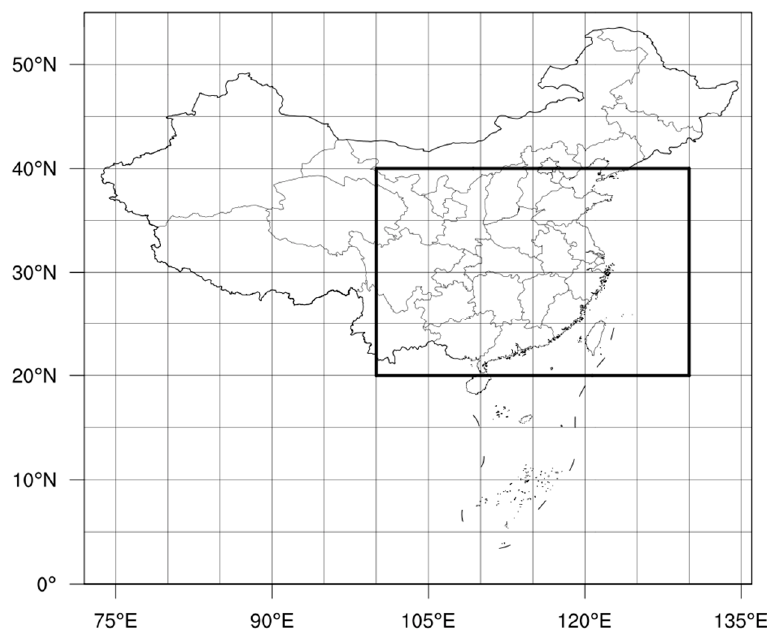
Figure 1. Analysis domain: the boundaries (small rectangle) of the southeast region (covering southeastern China) used to subset NCEP2 850-hPa winds for input to the k -means clustering algorithm.